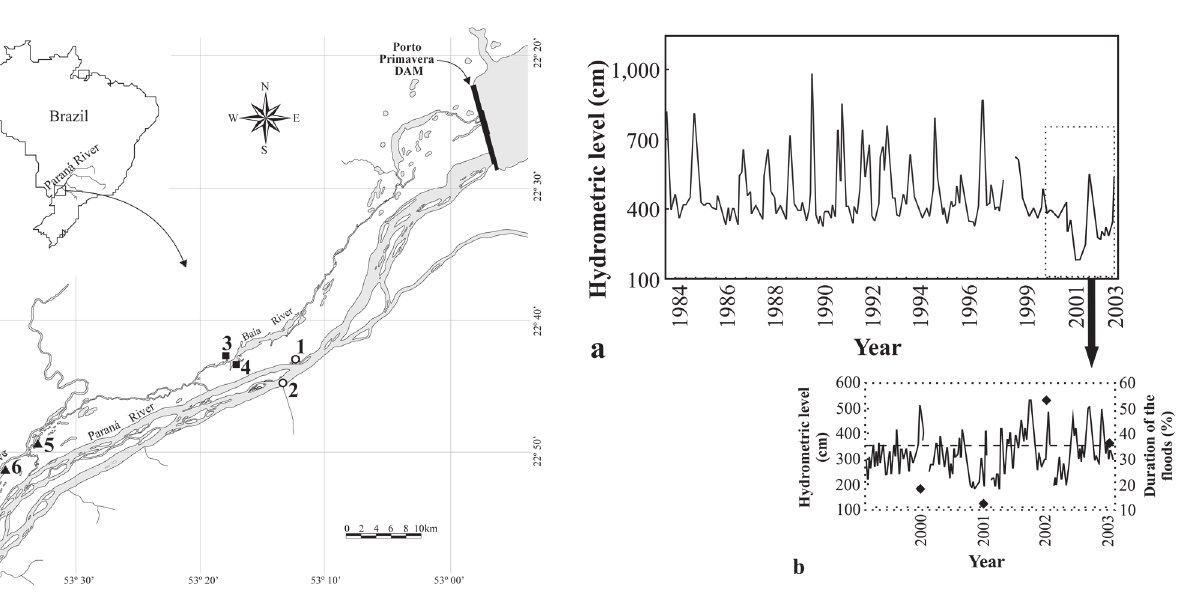
Fig. 1. Study area with location of the sampling stations in the main habitats (1 - Garças Lake, 2 - Paraná River channel, 3 - Guaraná Lake, 4 - Baía River channel, 5 - Patos Lake, and 6 - Ivinhema River channel) of the upper Paraná River floodplain.